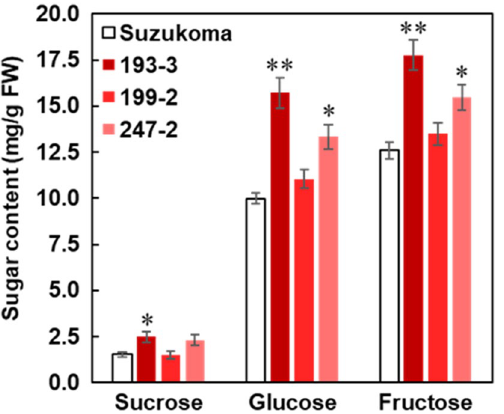
Figure 5. Sugar content of fruits from the SlINVINH1 genome edited lines. Sucrose, glucose and fructose content in mature fruits from original cultivar ‘Suzukoma’ and the SlINVINH1 genome edited lines (193–3, 199– 2, and 247–2). Error bars indicate standard error for 15 fruits from 5 plants. An asterisk indicates a significant difference (Dunnett’s test, * P < 0.05; ** P < 0.01).